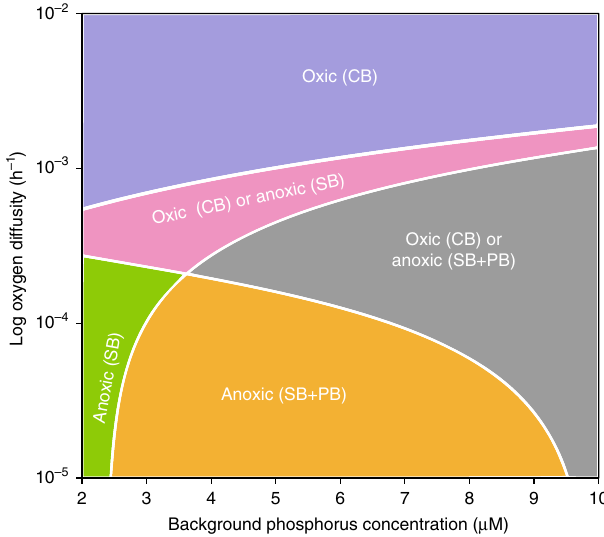
Fig. 4 Two-parameter bifurcation diagram. The diagram illustrates how the model predictions vary with phosphorus availability and oxygen diffusivity. Blue region = oxic state with cyanobacteria. Pink region = alternative stable states, with either cyanobacteria in the oxic state or sulfate-reducing bacteria in the anoxic state. Gray region = alternative stable states, with either cyanobacteria in the oxic state or coexistence of sulfate-reducing bacteria and phototrophic sulfur bacteria in the anoxic state. Green region = anoxic state with sulfate-reducing bacteria. Orange region = anoxic state with coexistence of sulfate-reducing bacteria and phototrophic sulfur bacteria. Parameter values are given in Supplementary Table